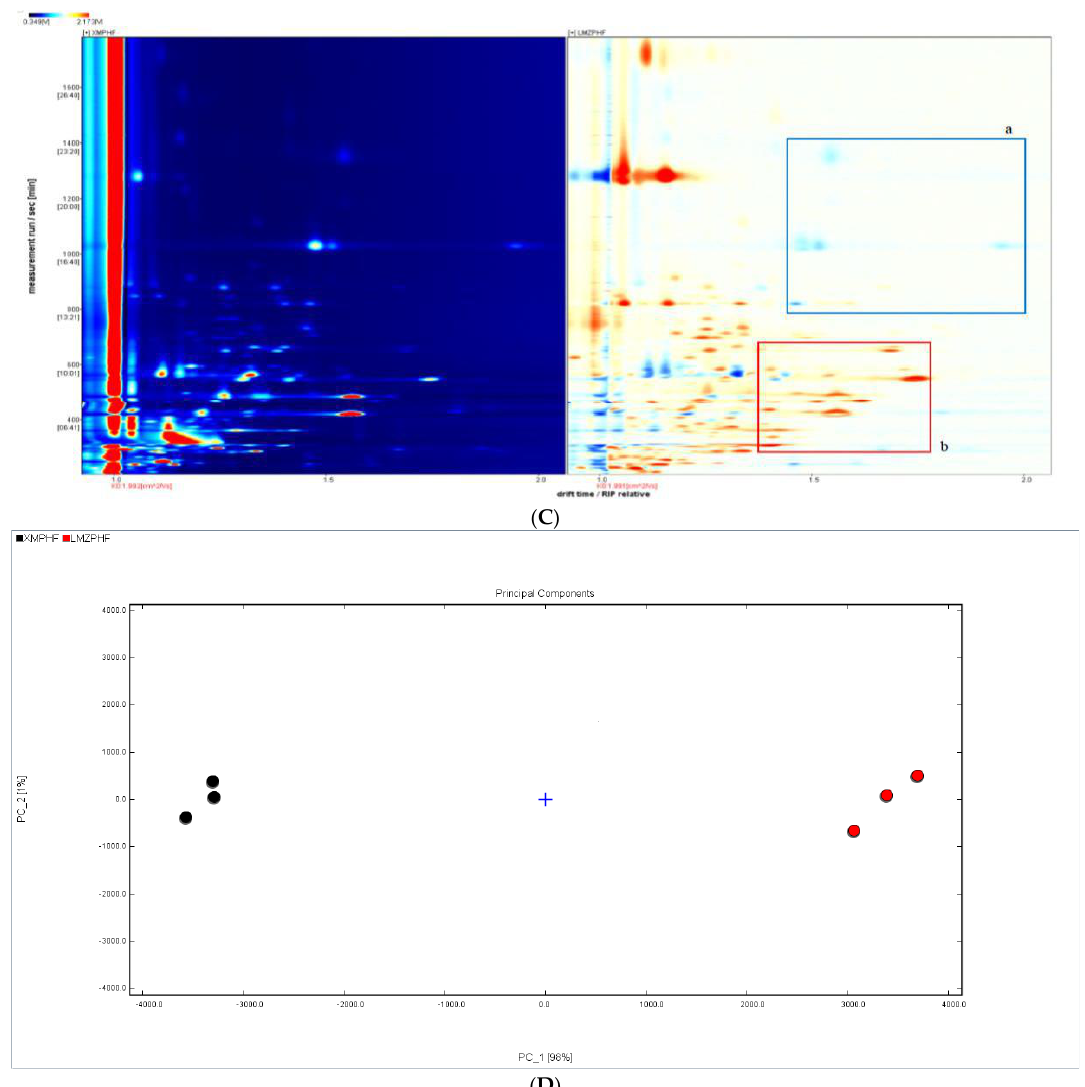
Figure 3. ( A ) GC−IMS three -dimensional spectra of REP and REPBR. ( B ) GC − IMS spectra of REP Figure 3. ( A ) GC—IMS three-dimensional spectra of REP and REPBR. ( B ) GC—IMS spectra of REP and REPBR (vertical view). ( C ) GC − IMS spectra of REP and REPBR (difference diagram). ( D ) PCA and REPBR (vertical view). ( C ) GC—IMS spectra of REP and REPBR (difference diagram). ( D ) PCA analysis diagram of REP and REPBR. analysis diagram of REP and